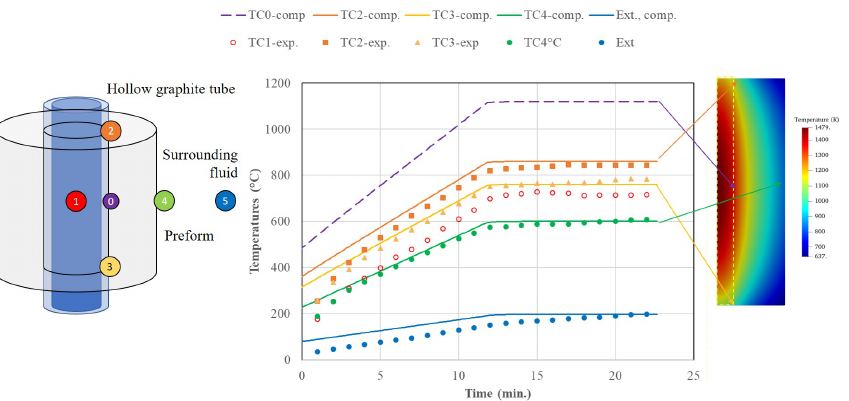
Figure 12. Computation of the thermal histories of selected points of the setup: ( left ) position of the sampled points; ( right ) thermal history of these points compared to experimental ones.